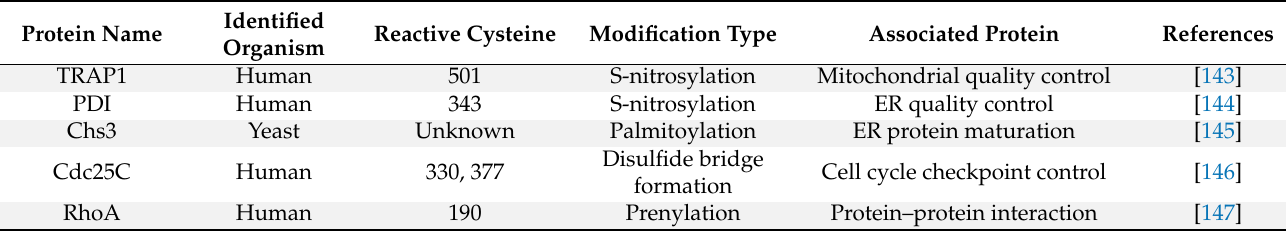
Table 2. Table of select proteins that contain different cysteine modifications, related to Figure 3. Cysteine modification sites are noted where experimentally verified, alongside general associated processes in which the protein is involved or during which it undergoes the relevant